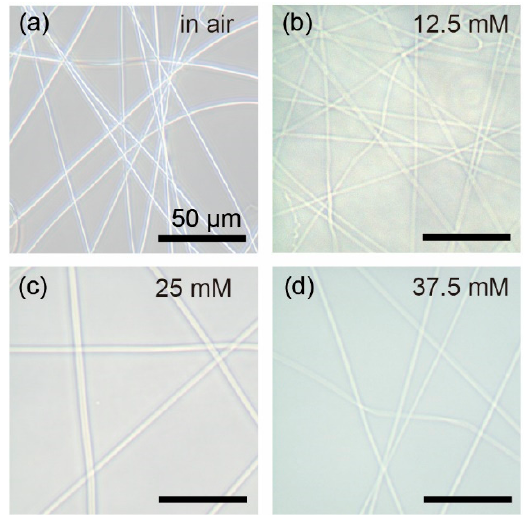
Figure 3. Optical microscopy images of gelatin- β CD-Ad fibers ( a ) before chemical crosslinking (in air) and ( b ) after crosslinking with [ EDC ] = [ NHS ] = 12.5 mM, ( c ) 25.0 mM, and ( d ) 37.5 mM in PBS.